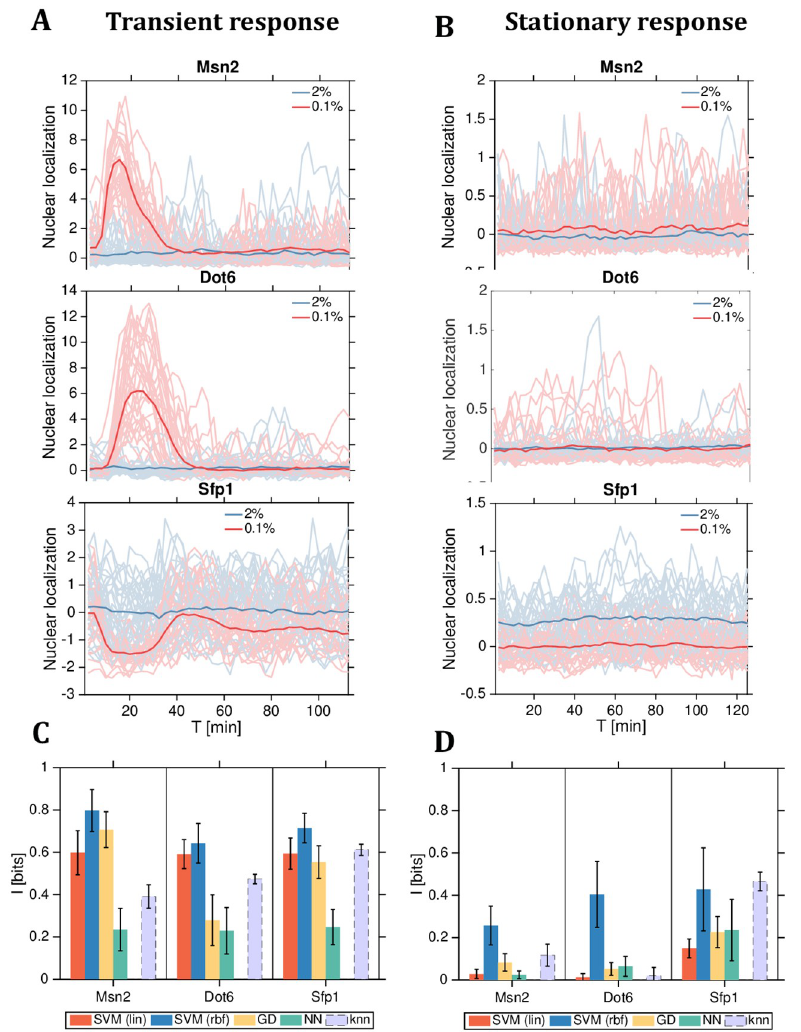
Fig 8. Two-level mutual information estimates from single-cell time-series data for nuclear translocation of yeast transcription factors. (A, B) Data replotted from Ref [27] for Msn2 (top row), Dot6 (middle row), and Sfp1 (bottom row); early transient responses (A) after nutrient shift at t = 0 min from glucose rich (2%, blue traces) to glucose poor (0.1%, red traces) medium are shown in the left column, stationary responses (B) are collected after cells are fully adapted to the new medium. Sampling frequency is 2.5 min, d = 45, and the number of sample trajectories per nutrient condition is N = 100. Thin lines are individual single cell traces, solid lines are population averages. (C, D) Information estimates for the transient (left, C) and stationary (right, D) response periods. Colored bars use model-free decoding- based estimators as indicated in the legend, gray bar is the knn estimate; error bars computed from estimation bootstraps by randomly splitting the data into testing and training